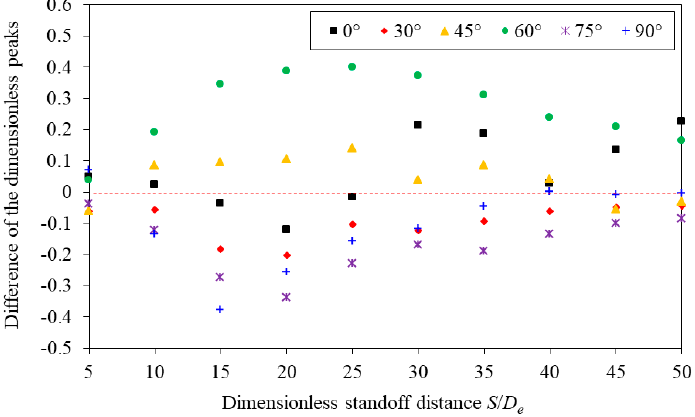
Figure 8. The dimensionless pressure oscillation amplitude against dimensionless standoff distance.